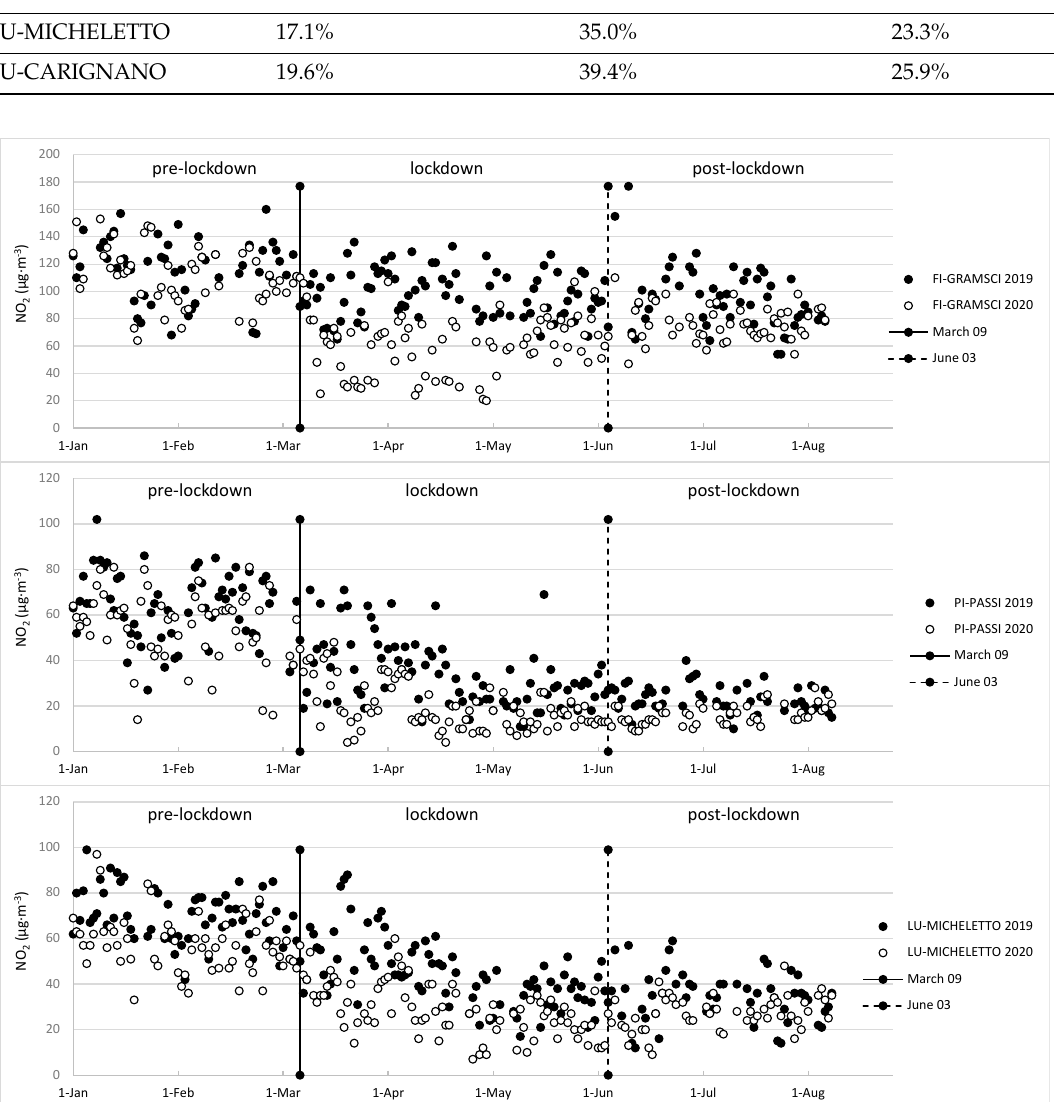
Figure 4. The daily mean concentration of NO 2 ( μ g ∙ m − 3 ). The area between the vertical bars in each graph indicates the duration of the lockdown.